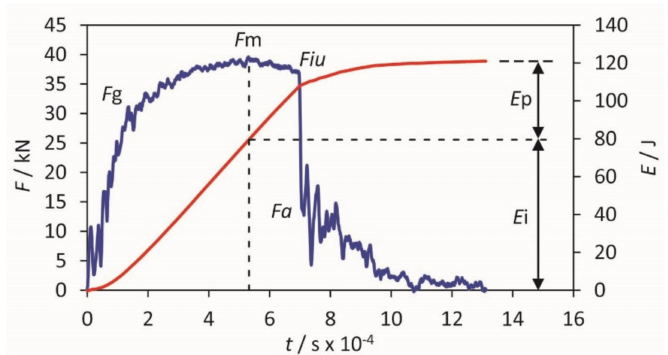
Figure 4. Principle of dividing the total impact energy KV into energy for crack initiation E i and energy for crack propagation E p ; the diagram belongs to the sample of FGHAZ-1 without PWHT.